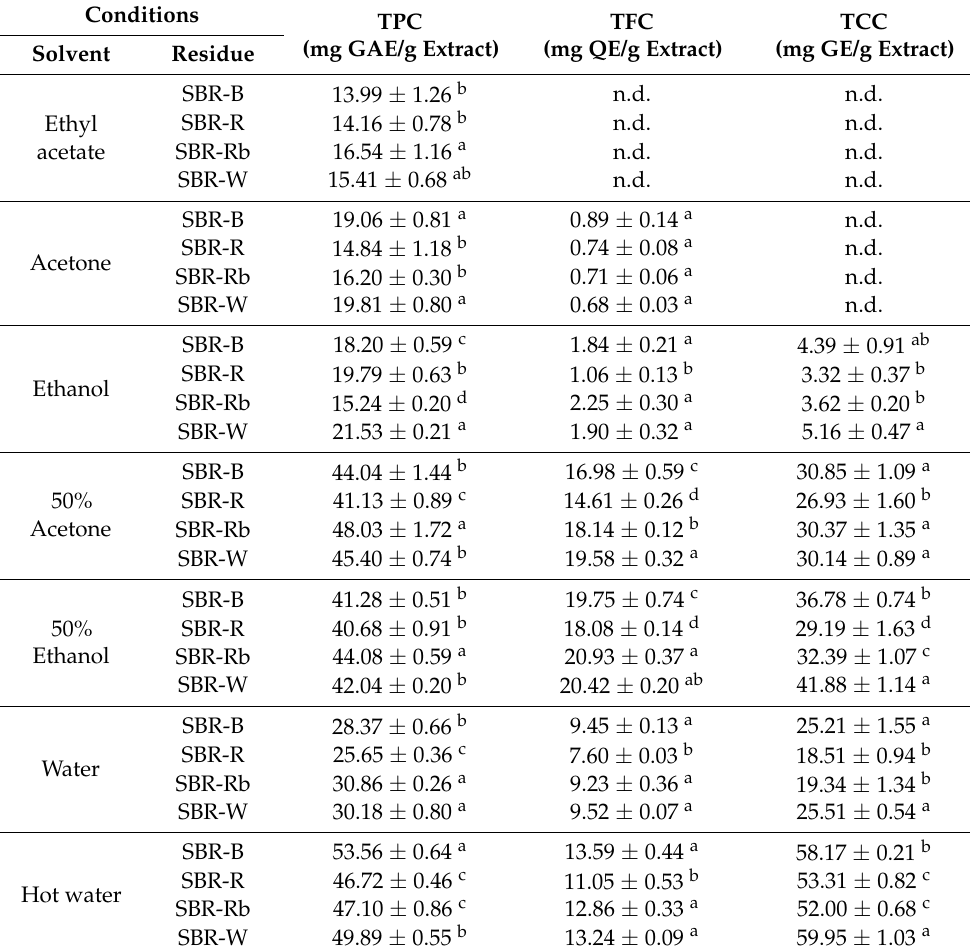
Table 3. Total phenolic content (TPC), total flavonoid content (TFC), and total carbohydrate content (TCC) of solid-based residues (SBRs) extracted using different